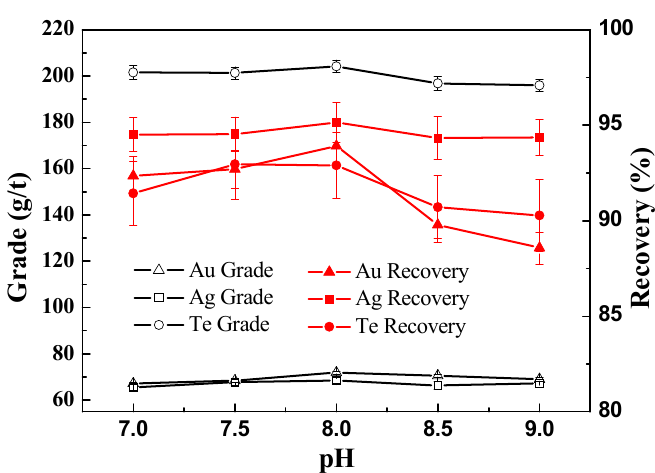
Figure 4. Flotation recovery and grade of Te, Au, and Ag as a function of pulp pH value (content of − 0.074 mm (70%); pulp density: 33%; butyl xanthate: 120 g/t).